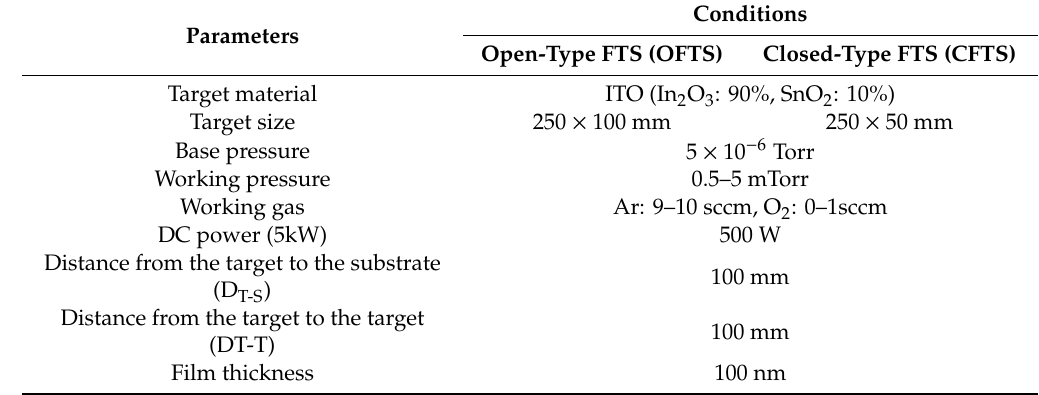
Table 1. Comparison of detailed sputtering conditions by the magnet